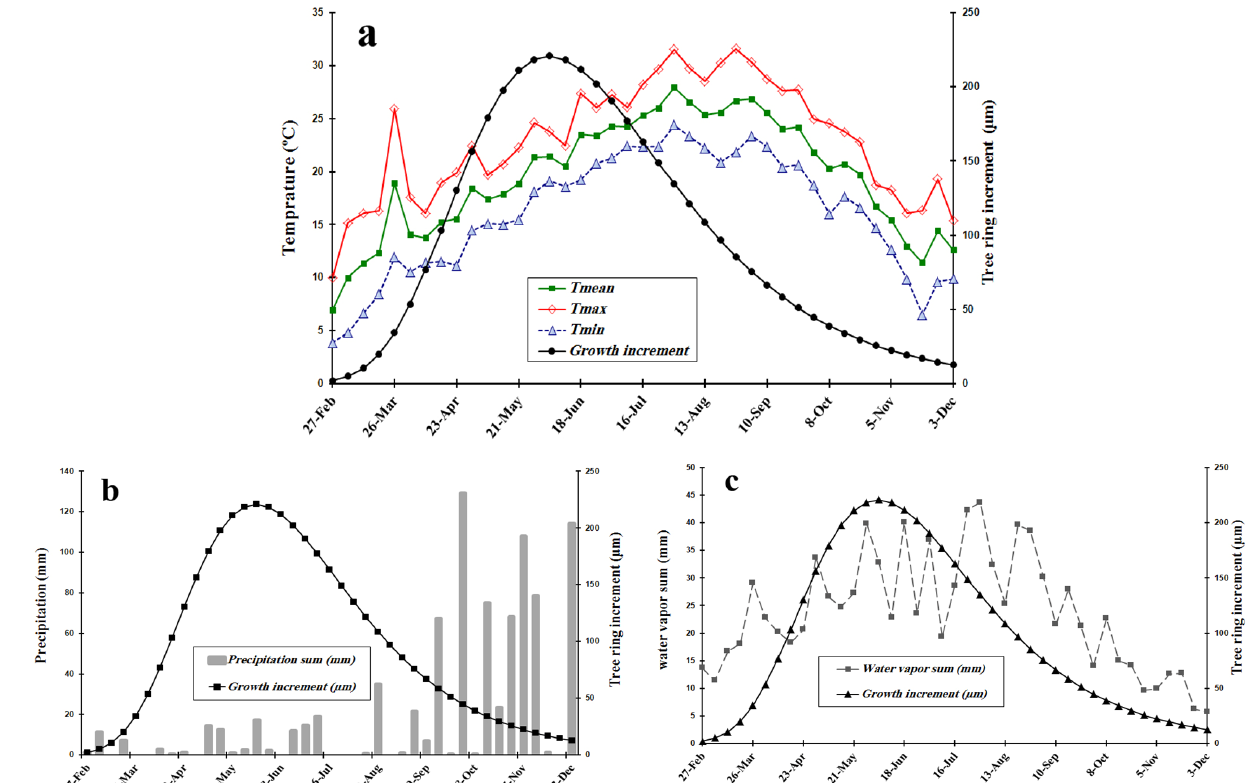
Fig. 3. Weekly changes in mean, maximum and minimum air temperature (a), precipitation sums (b) and water evaporation sums (c) and weekly increase in average ring width of trees during 2008 growing season. Interval between tick markers in horizontal axis is 4